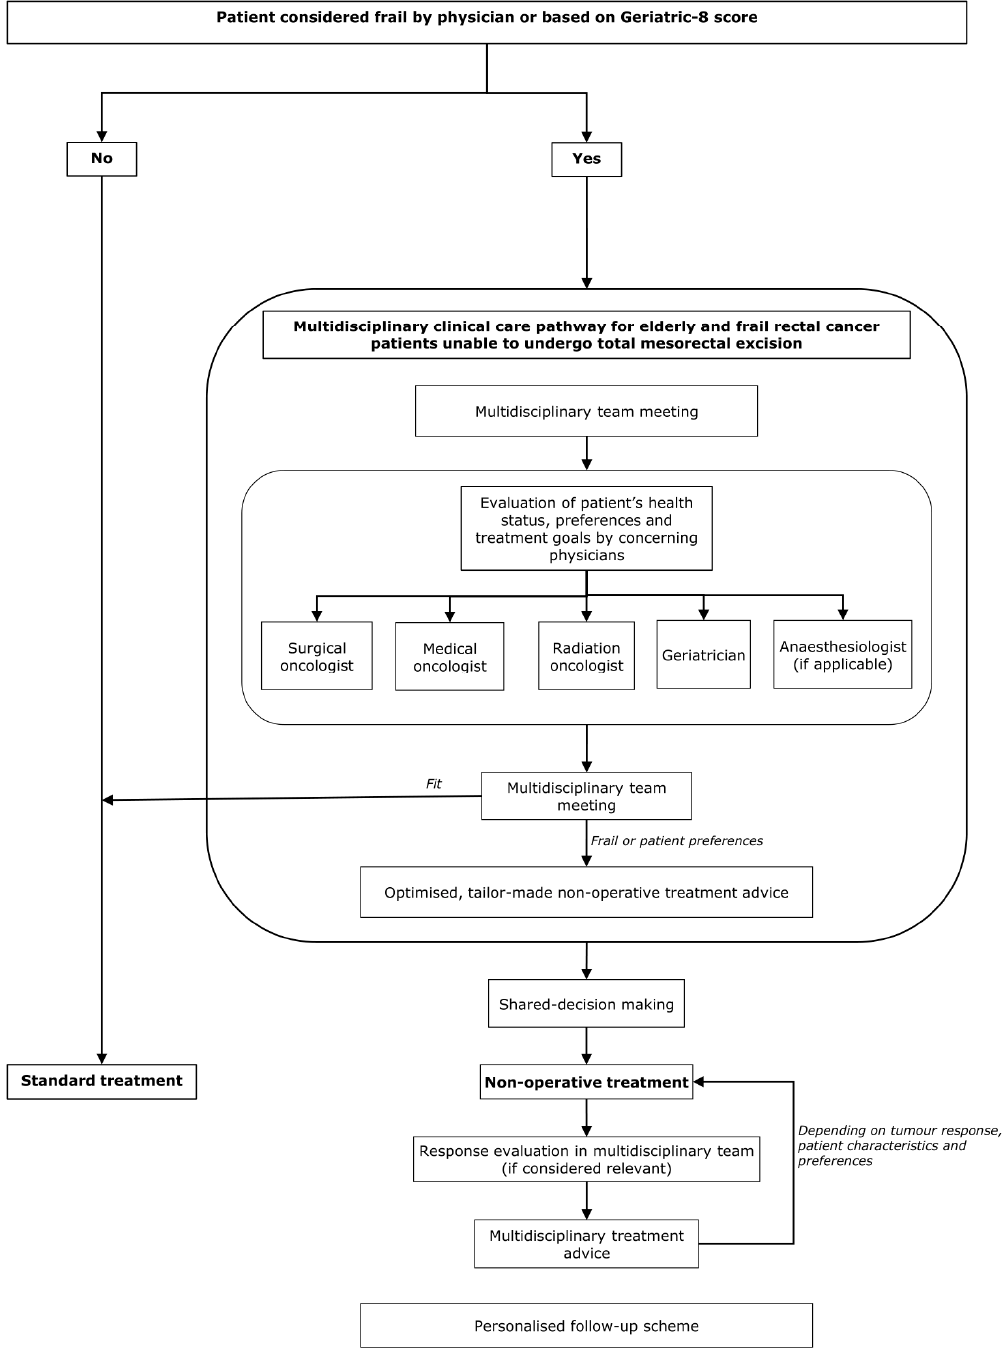
Figure 1. Flowchart of the multidisciplinary clinical care pathway for elderly and frail rectal cancer patients that has been successfully implemented by the authors of the study.